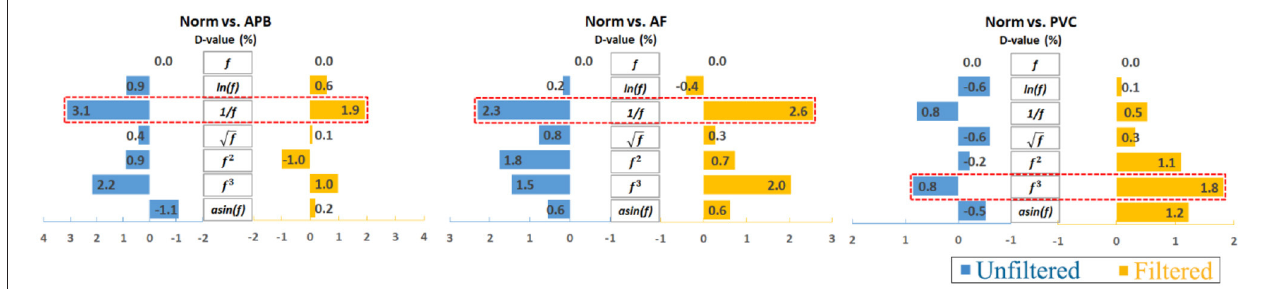
FIGURE 5 | Overall D-value changes after averaging the unbalanced, RUS, and SMOTE results. Note that the reciprocal is the most consistently effective data